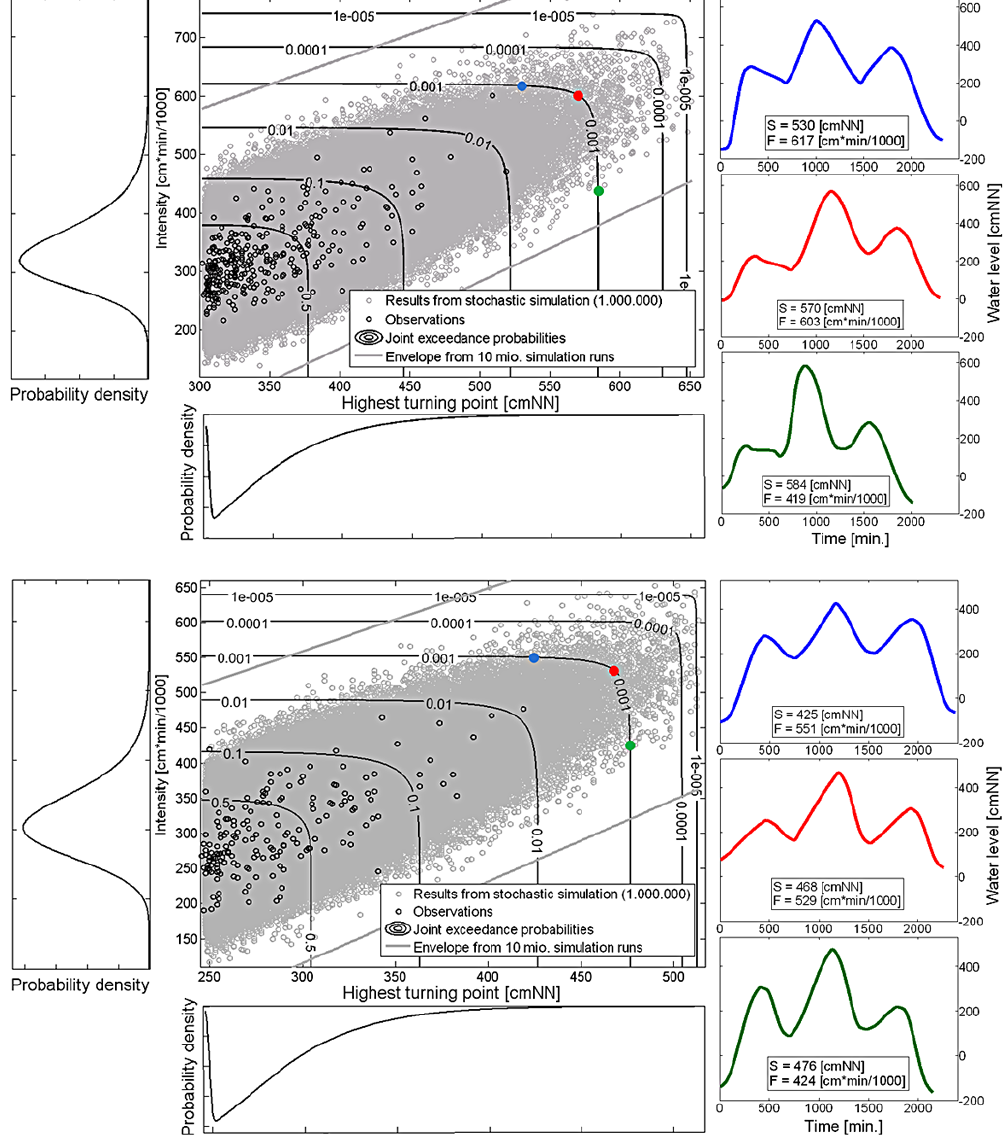
Fig. 9. Results from statistically analysing the observed and stochastically simulated storm surge events for the tide gauges of Cuxhaven (top) and H¨ornum (bottom) based on KDFs (as marginal distributions) and the Gumbel Copula and selected simulated storm surge events with a occurrence probability of P e = 0.001 [1 /a ]